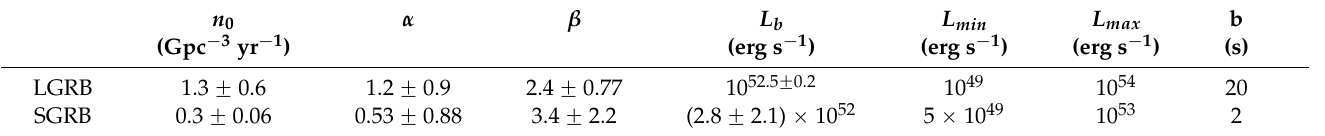
Table 2. Parameters of the LGRB and SGRB broken power law luminosity function [53,55] and burst durations. n 0 is the rate density at z “